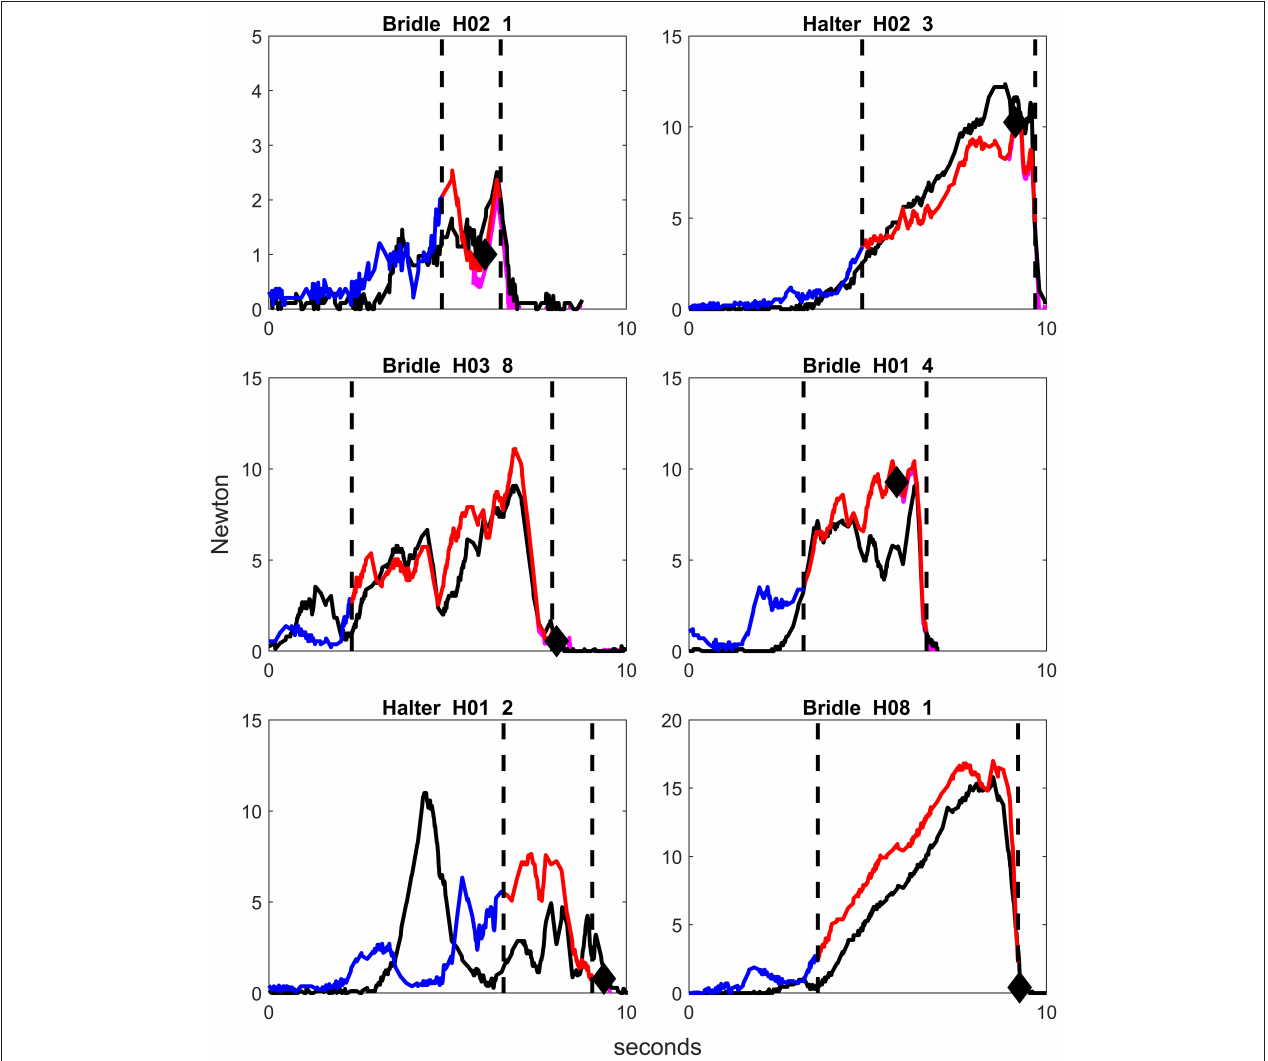
FIGURE 3 | Examples of graphs of rein tension signals using bridle or halter in different horses, from repetitions where the handler applied rein tension for one step back and with no other behavioral response than backing. Blue color on the rein tension curve illustrates the phase picking up the reins, red color illustrates the rein tension signal, and purple illustrates the horse stepping back. Only the right rein is colored. The first vertical dotted line demonstrates the onset of the rein tension signal and the second vertical dotted line displays the lowering of the handler’s hands, i.e., release of the rein tension signal. The black diamond signifies the onset of backing. H = Horse, first number is horse number, second number is repetition number. Note that the scale on the y-axis differs slightly between graphs.